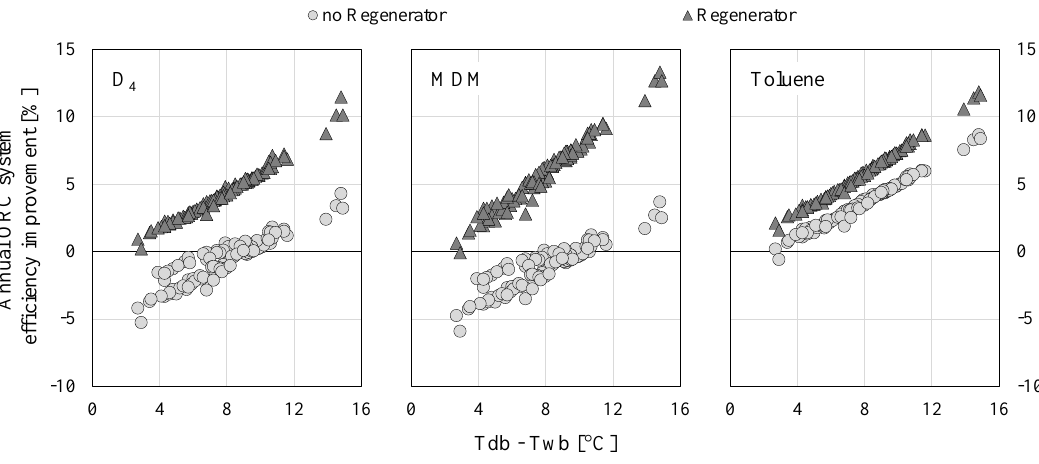
Figure 13. Impact of condenser type on annual ORC system